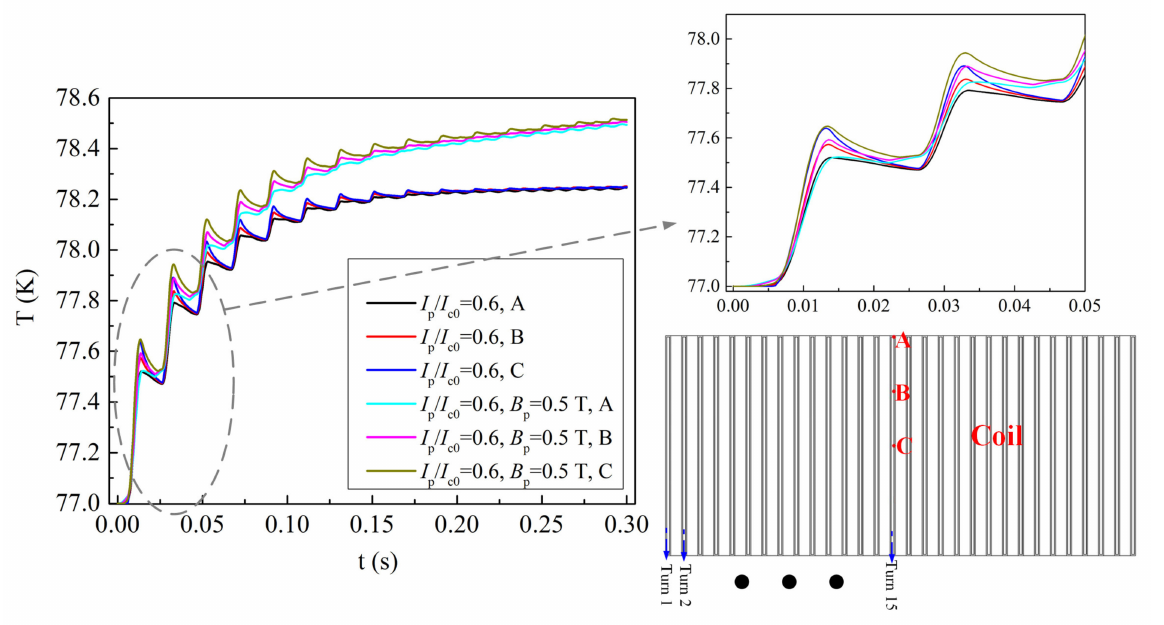
Figure 13. The temperature of the 15th turn of the tape in the coil changes with time at positions A, B and